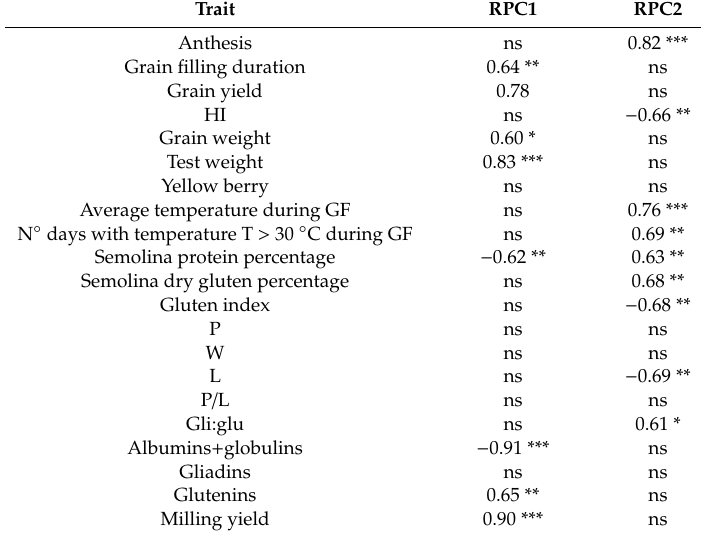
Figure 1. Principal Component Analysis graph for phenological, productive, and semolina quality traits; empty symbols: 2007; solid symbols: 2006; circles: old cultivars; triangles: intermediate cultivars; squares: modern cultivars. Table 6. Component loadings indicating the correlation between the components and the original variables.